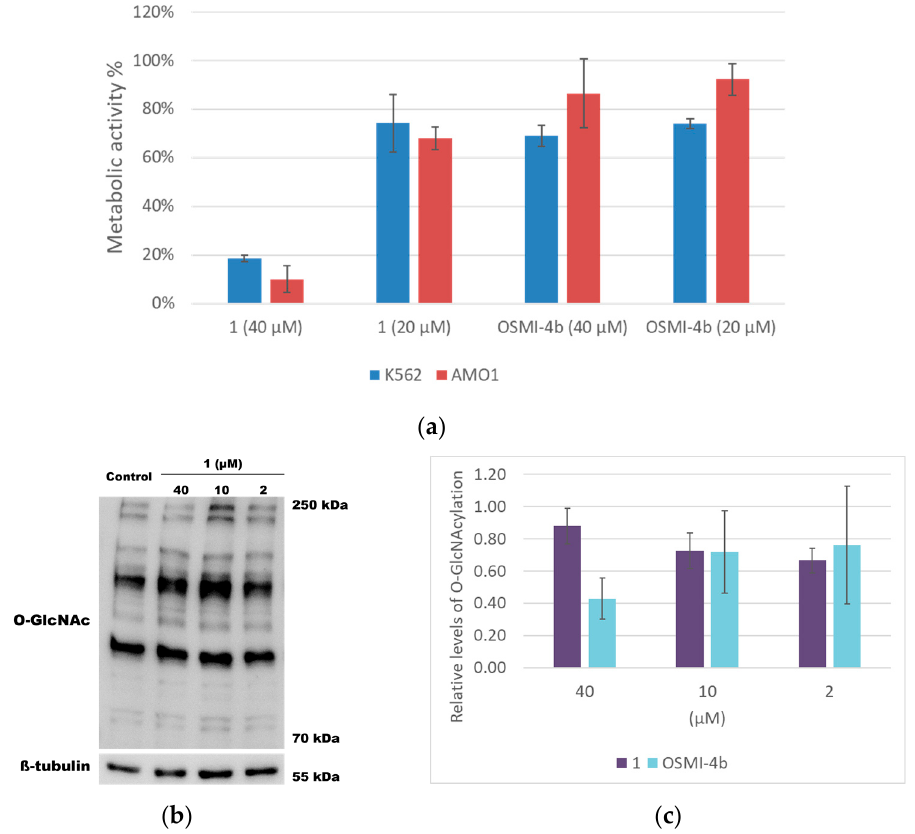
Figure 4. Cellular activity of OGT inhibitor 1. ( a ) Metabolic activity after treating K562 and AMO1 cells with 1 and OSMI-4b for 72 h at 40 and 20 µM. The results are presented as the percentage of metabolic activity of the control cells stimulated with the vehicle (mean + SD) from two independent experiments. ( b ) Representative picture of Western blot analysis of O -GlcNAc levels after treating AMO1 cells with 1 or vehicle for 4 h (two independent experiments). ß-tubulin was used as the loading control. ( c ) The Western blot results are presented as the relative level of O -GlcNAcylation of the control AMO1 cells stimulated with the vehicle for two independent experiments. OSMI-4b was used as the positive control (Figure S7).